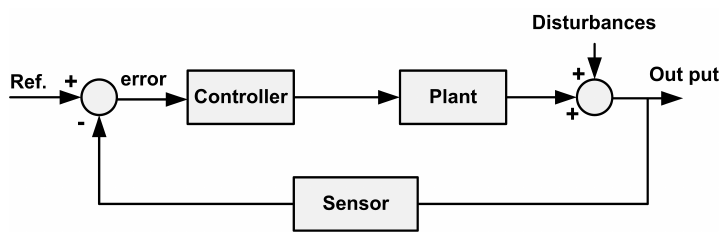
Figure 2. The block diagram of a general air handling unit (AHU) feedback